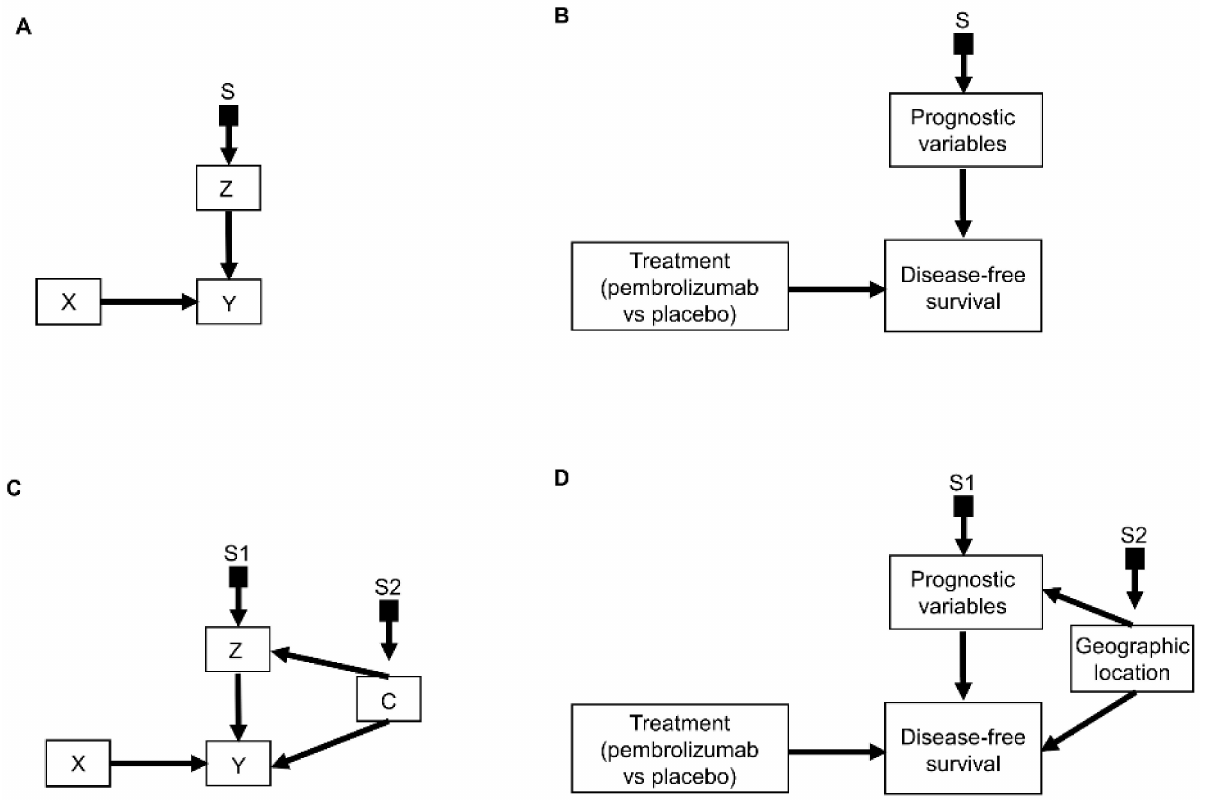
Figure 6. Selection diagrams representing the risk modeling approach recommended by the Predictive Approaches to Treatment effect Heterogeneity (PATH) statement: ( A ) Risk modeling approach where the outcome Y is determined by a randomized treatment X and baseline risk Z. The selection node S indicates that baseline risk can shift across populations; ( B ) Risk modeling scenario whereby DFS is influenced by the randomized treatment choice between adjuvant pembrolizumab or placebo and by each patient’s baseline risk as determined by RCC prognostic risk models such as the Assure nomogram. The selection node S indicates that baseline prognostic variables for DFS risk can shift across populations; ( C ) Scenario where one or more confounders C may influence baseline risk Z and treatment outcome Y. The selection nodes S1 and S2 indicate that baseline risk Z and confounder C, respectively, can shift across populations; ( D ) Corresponding clinical scenario where geographic location influences both the baseline prognostic risk and the survival outcomes of patients with RCC. The selection nodes S1 and S2, respectively, indicate that baseline prognostic variables and geographic location can shift across